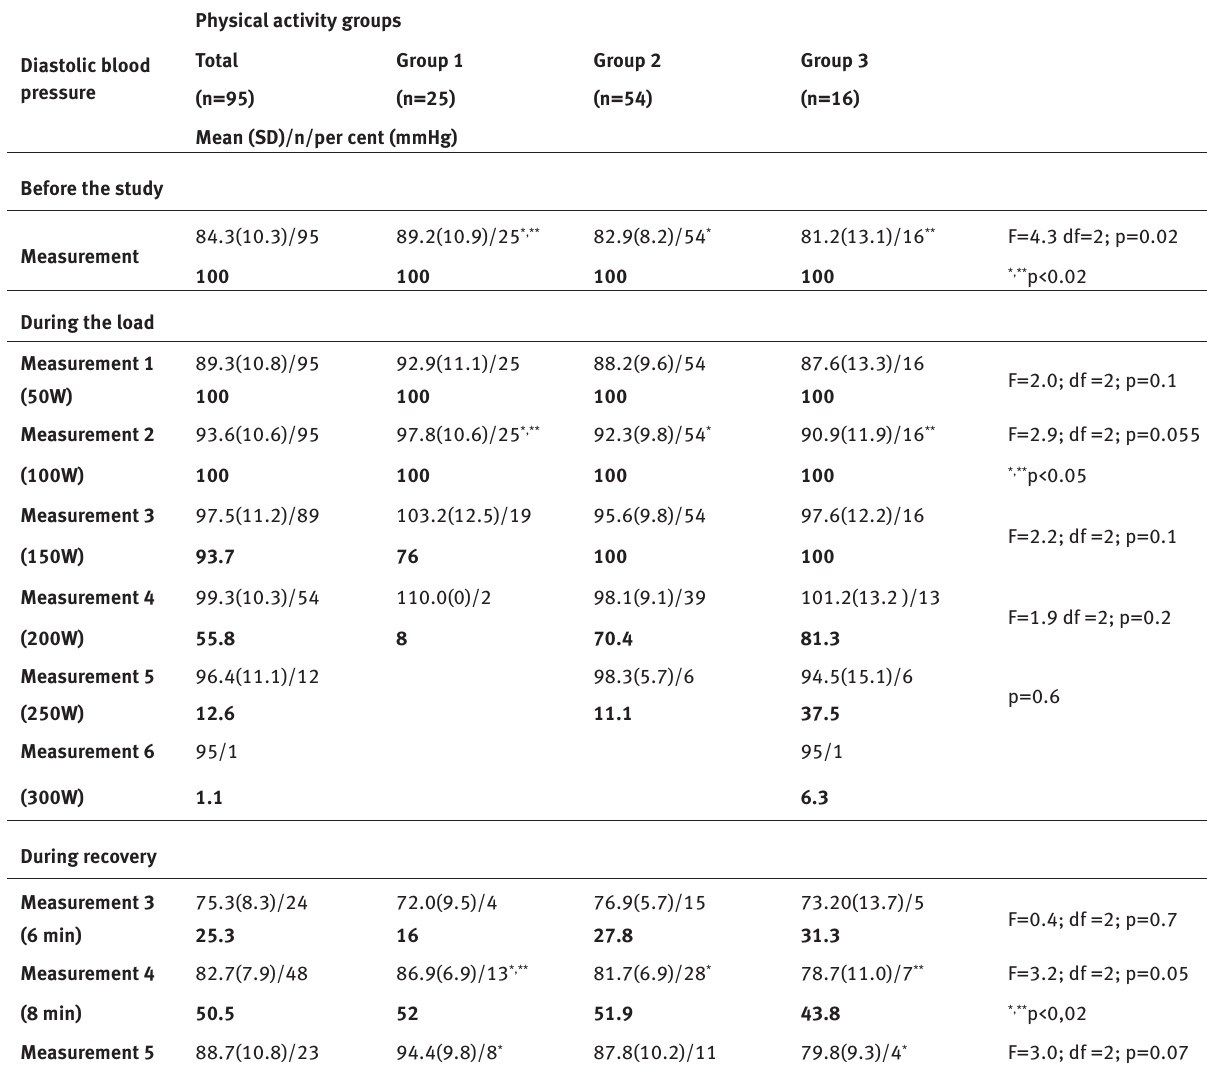
Table 4: Diastolic blood pressure in subjects before the study and its changes during physical load and recovery time taking into account physical activity